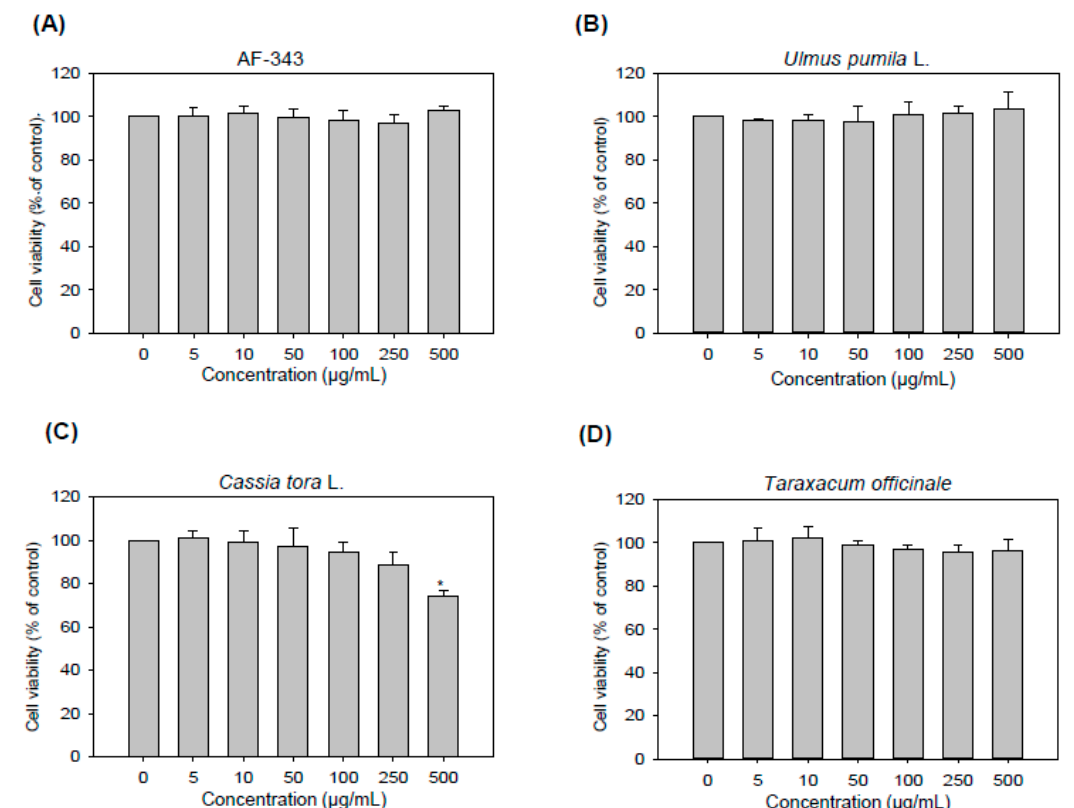
Figure 1. Cytotoxicity of AF-343 and the individual extract components toward rat basophilic leukemia (RBL-2H3) cells. ( A – D ) RBL-2H3 cells were treated with various concentrations (5, 10, 50, 100, 250, and 500 μ g/mL) of AF-343 and extracts of Ulmus pumila L., Cassia tora L. and Taraxacum officinale for 48 h. Cell viability was measured using a Cell Counting Kit (CCK)-8 assay. The results are expressed as the mean ± SD from three independent experiments. * p < 0.05 vs. the compound 48/80 only group.